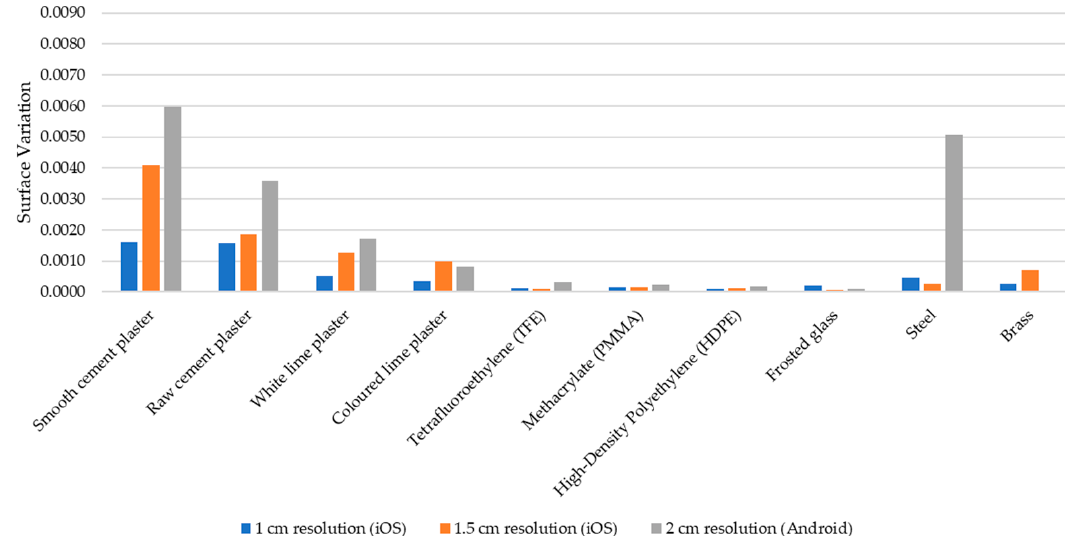
Figure A2. Comparison of mean values of surface variation for samples scanned at a distance of 1.5